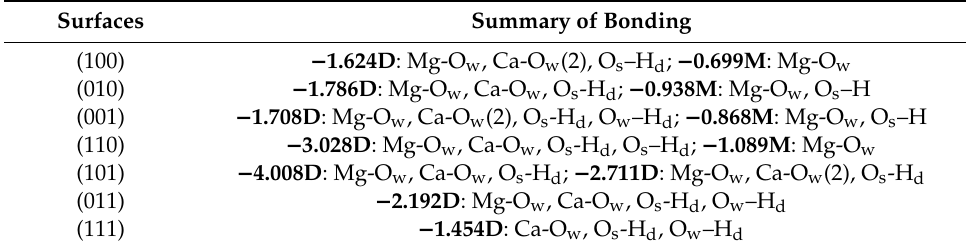
Table 4. Adsorption configurations of the H 2 O over Mg-doped M3-C 3 S surfaces with respect to the adsorption energy in